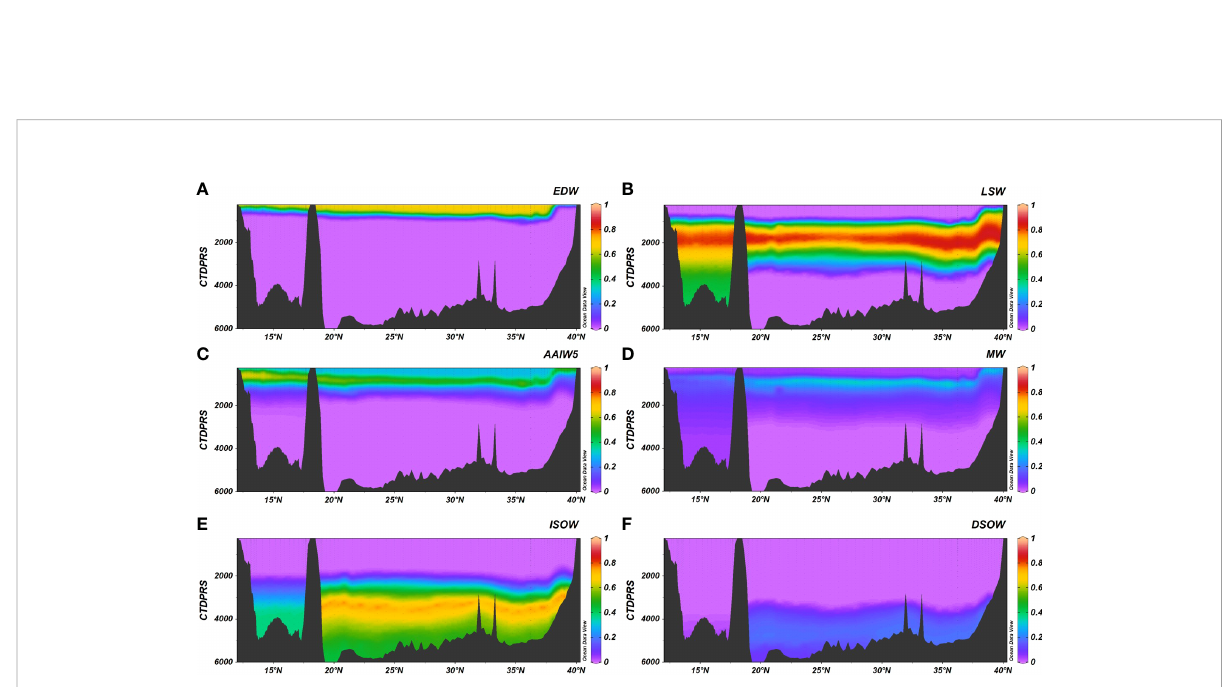
FIGURE 6 A22 section for the contribution of the water masses (A) EDW, (B) LSW, (C) AAIW5, (D) MW, (E) ISOW, (F) DSOW. Figure with the Ocean Data View software (Schlitzer,